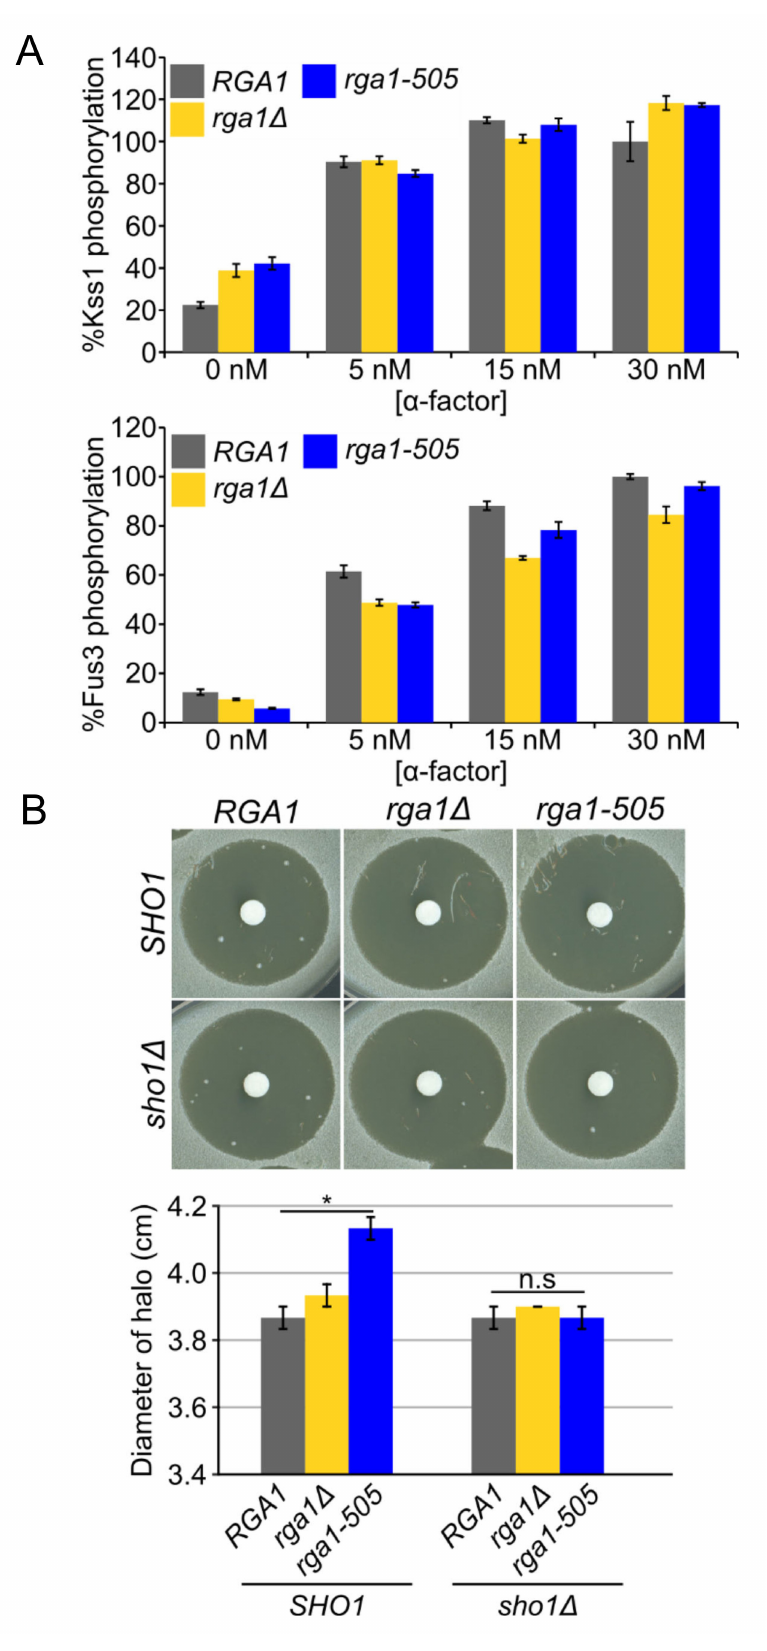
Figure 4. Rga1 does not negatively regulate mating pathway MAPK activation in response to